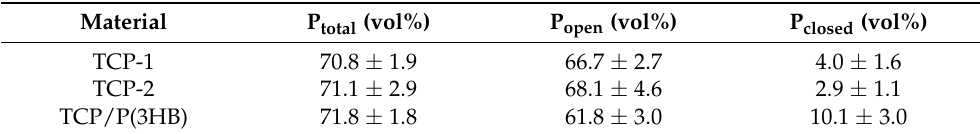
Table 3. The porosity of studied materials.